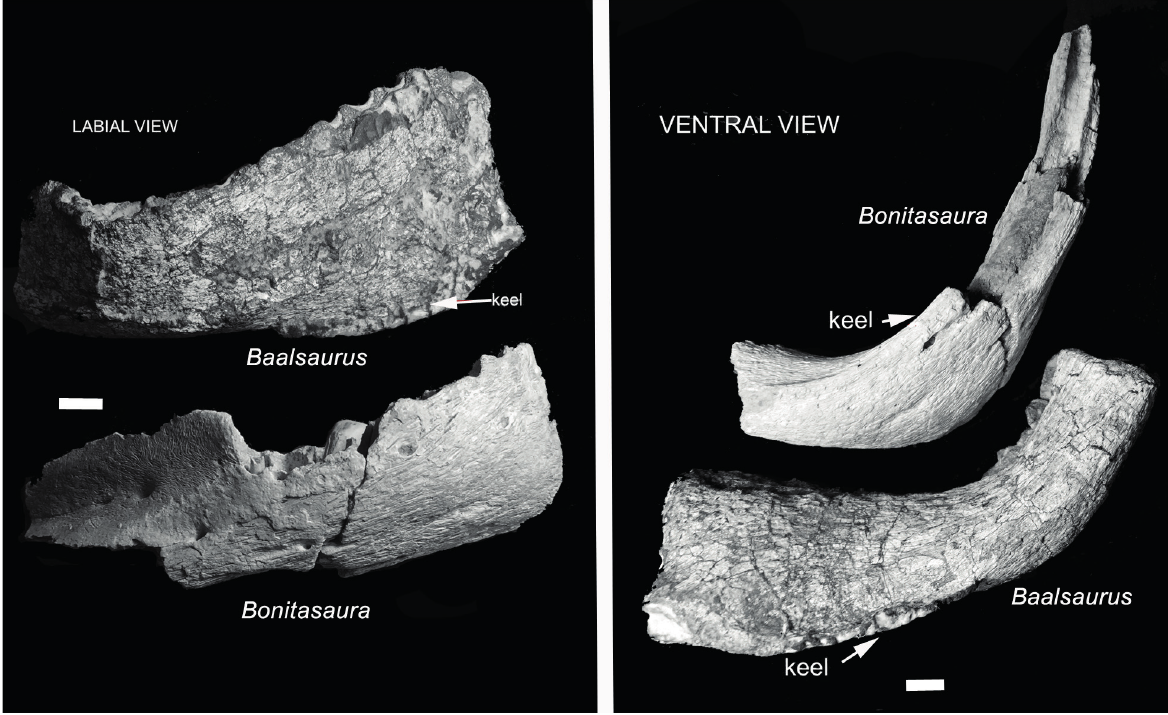
Figure 5 - Baalsaurus mansillai n.g.n.sp. labial and ventral view compared with Bonita aura salgadoi. Scale bar: 1 cm.